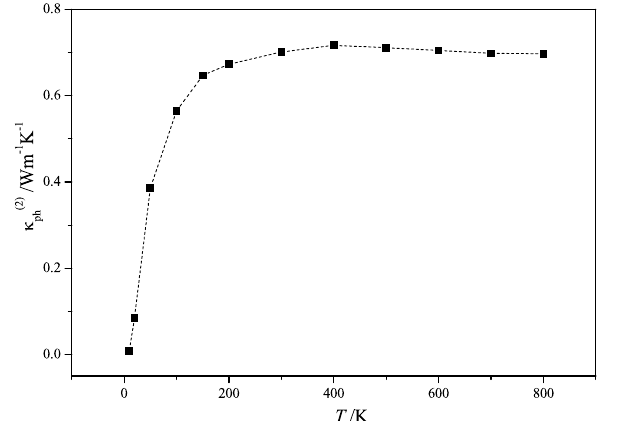
Figure 8. Temperature dependence of lattice thermal conductivity coefficient κ ph(2) of Cu 7 PS 6 obtained by using the results of molecular dynamics calculations and relation